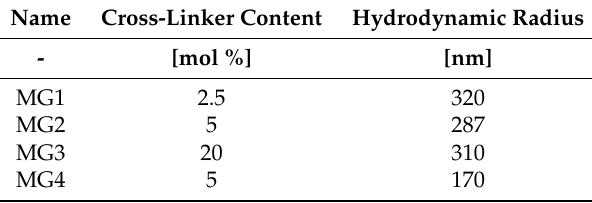
Table 1. Cross-linker content and hydrodynamic radius of the